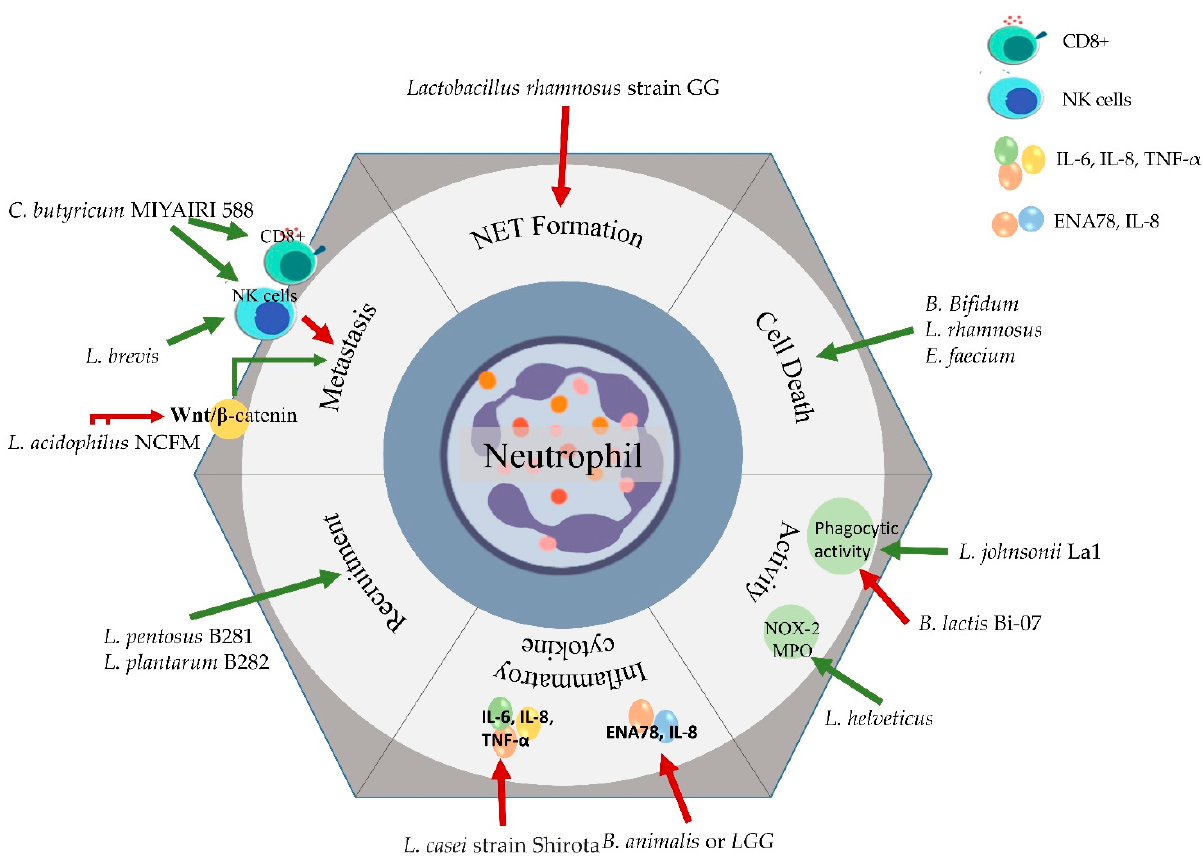
Figure 5. Effect of probiotics on neutrophil activity in cancer condition. Key: red arrows indicate inhibition and green arrows indicate promotion.